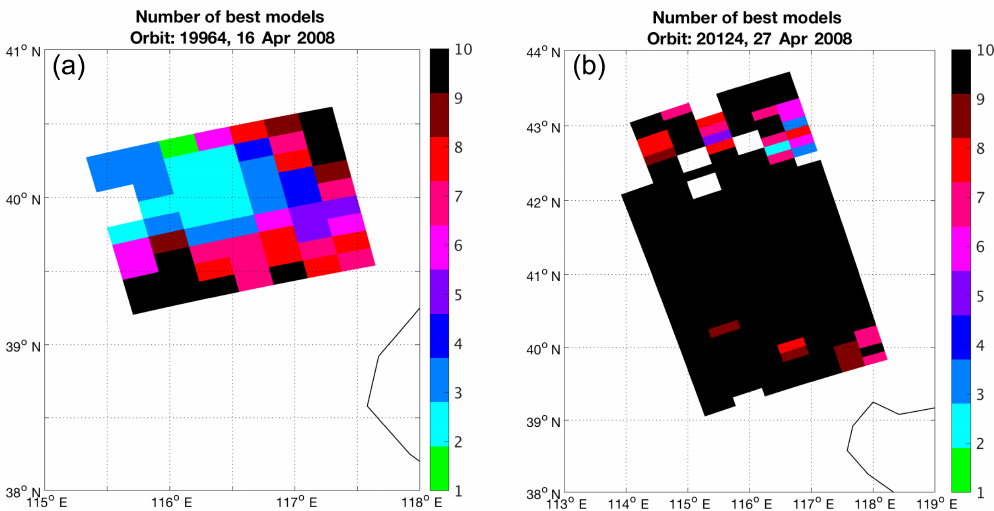
Figure 2. The number of most appropriate aerosol microphysical models at the retrieved pixels on 16 April (a) and 27 April (b) .